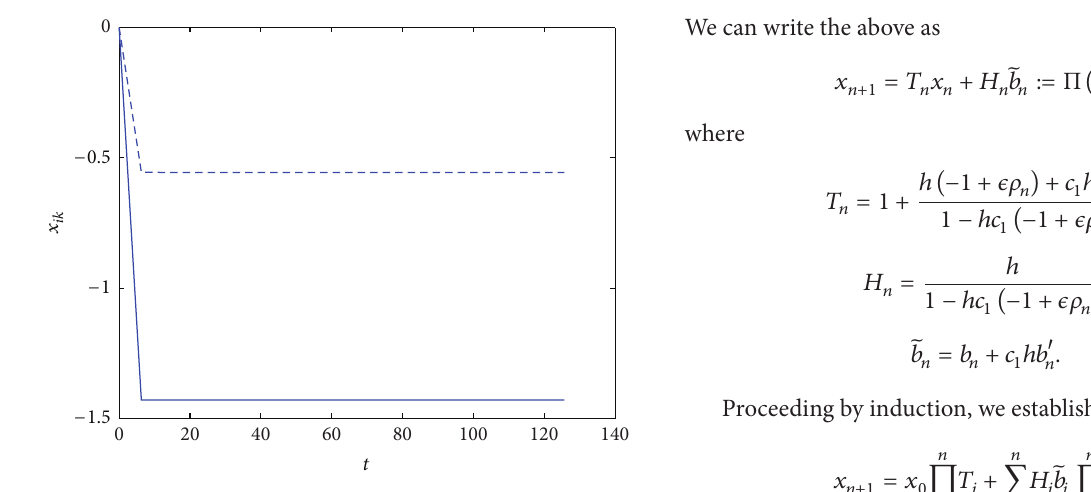
Figure 2: Numerical results of (32) using linearized implicit midpoint method: 𝑘 = 3 (—) and 𝑘 = 10 (– ––).